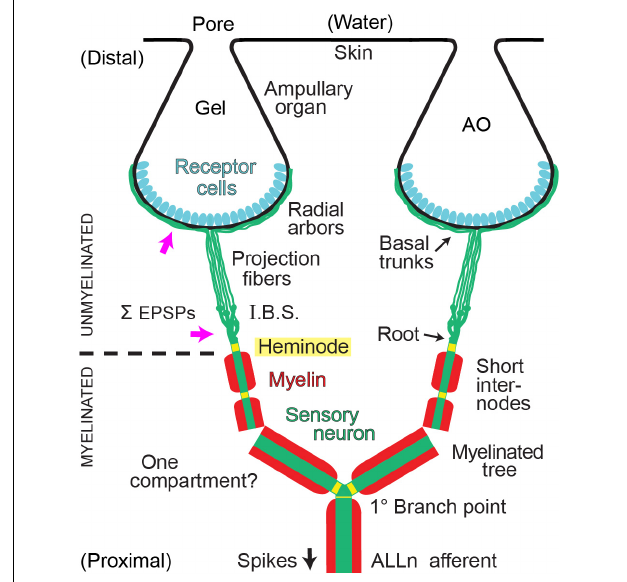
FIGURE 1 | Summary of afferent branching at a Polyodon electroreceptor. Distal ampullary organs (AO) were innervated by local unmyelinated arbors from all afferents. Central myelinated (red) arbors, located deeper, received input from all ampullary organs in a receptive field. ALLn, Anterior lateral line cranial nerve. I.B.S., Inline branching structure, the origin of an unmyelinated arbor, converged onto its root. Pink arrows indicate sites where summation ( (cid:54) ) of excitatory postsynaptic potentials (EPSPs) from receptor cells likely occurs. One compartment?: The wide dendrites of the central myelinated tree of each ALLn afferent likely form a strongly coupled electrotonic